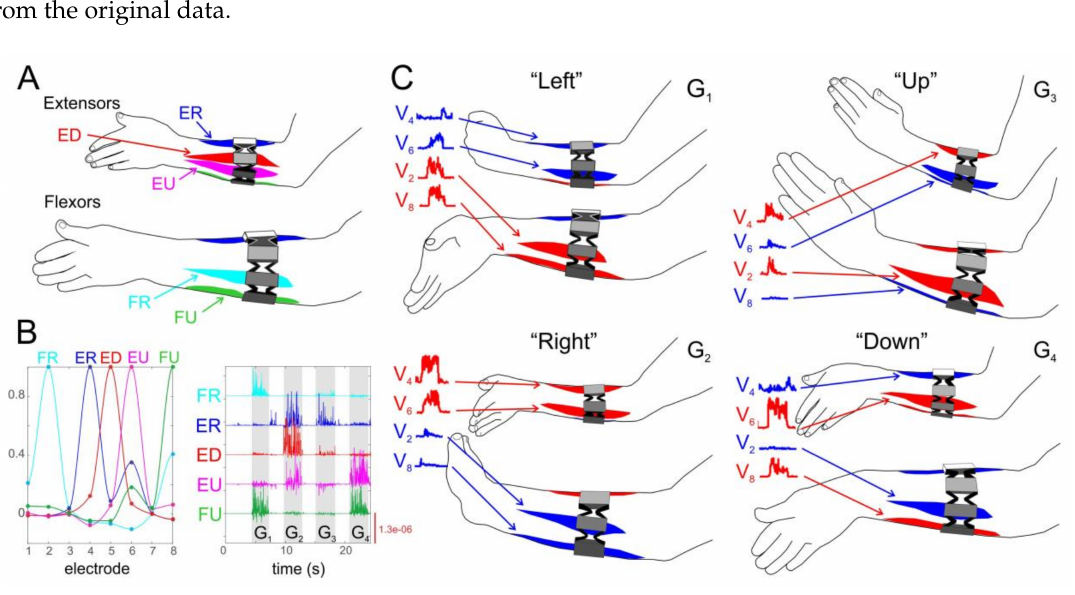
Figure 3. Synergist–antagonist coefficient describing the muscle functional efficiency. ( A ) Sketch of five main muscles (in two mirrored projections) involved in synthetic gestures G 1 –G 4 : extensor carpi radialis longus (ER), extensor digitorum (ED), extensor carpi ulnaris (EU), flexor carpi radialis (FR), and flexor carpi ulnaris (FU). ( B ) Independent component analysis of an sEMG recording. The loadings of five components (left) and the corresponding activations (right), while a subject performs four main gestures G 1 –G 4 . ( C ) Traces of activations of two synergist and two antagonist muscles (in red and blue, respectively) for each of the gestures G 1 –G 4